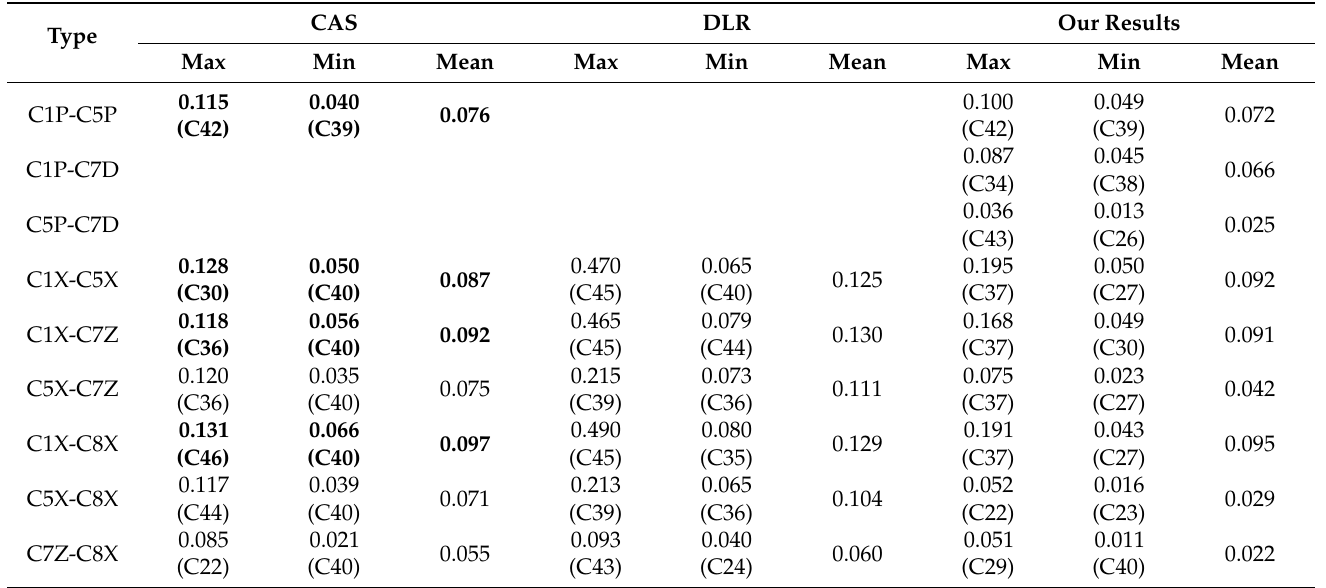
Table 3. Mean STD of BDS-3 DCBs of DLR, CAS, and our results, showing the corresponding satellite